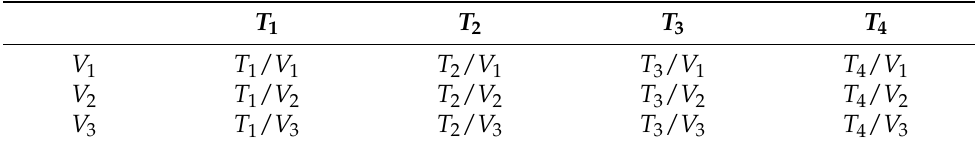
Table 3. Example of an ETC